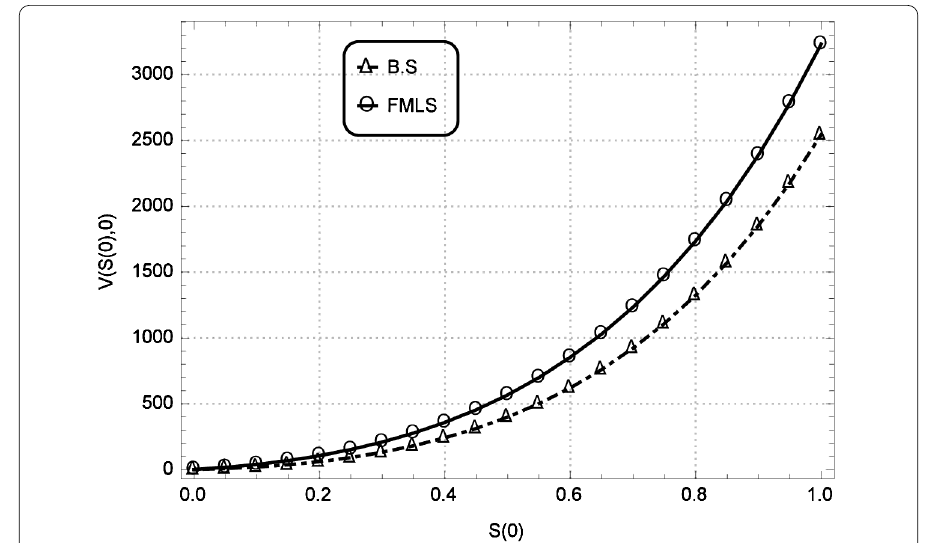
Figure 3 Simulated stock paths of BS and FMLS models at γ = 2, t =